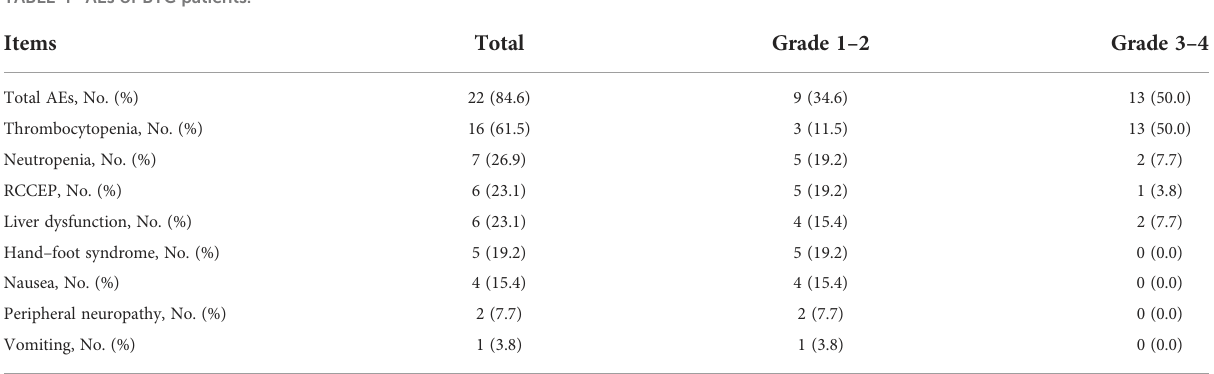
TABLE 4 AEs of BTC patients.